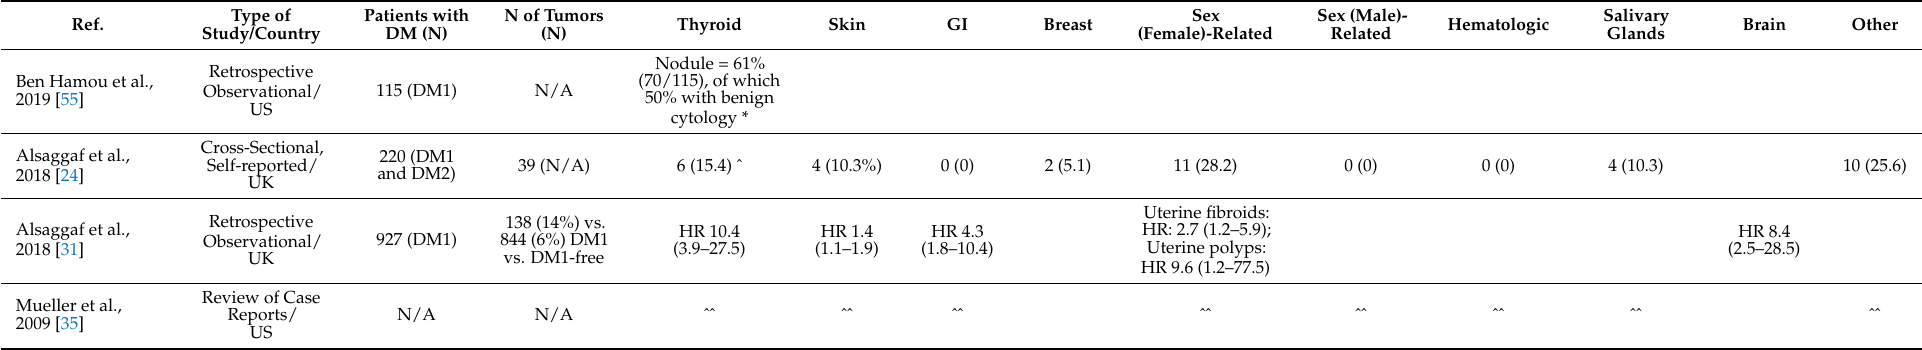
Table 4. Frequency of benign tumors reported in the